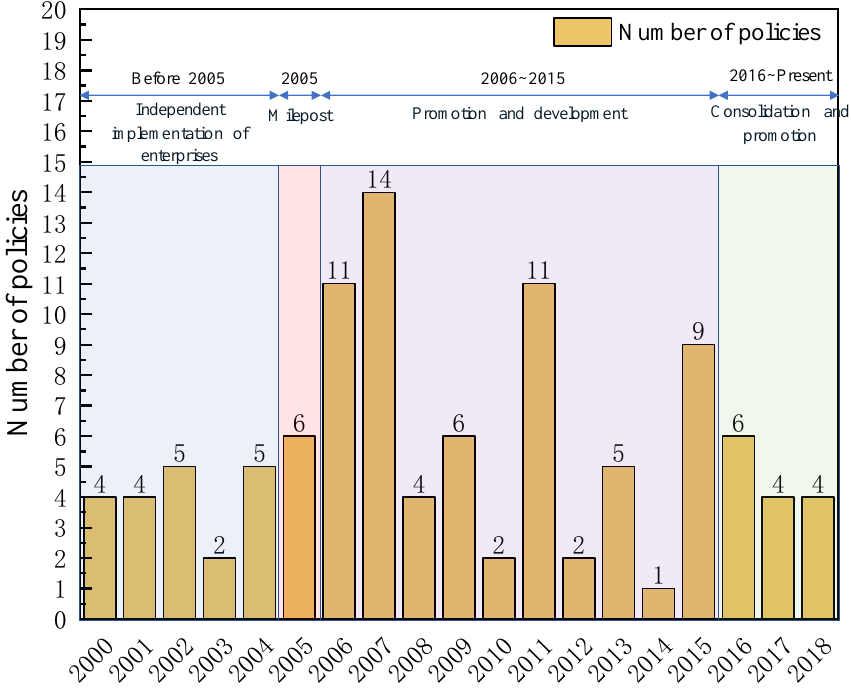
Figure 16. Development stage and quantity distribution of gas control policies.